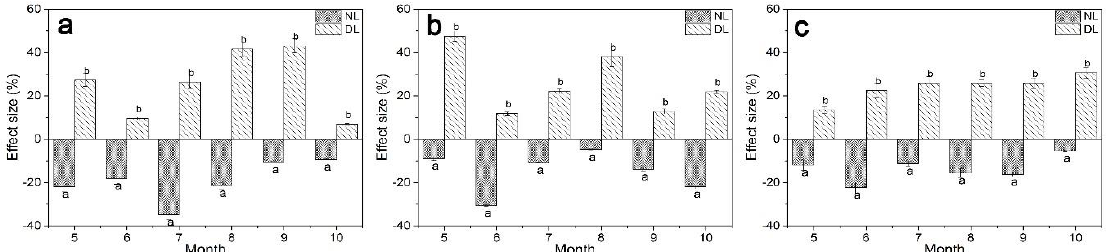
Figure 2. Effect size of NL (no-litter) and DL (double litter) treatments on soil respiration rates during the study period (May to October in 2018) in different-aged Betula platyphylla forests of the permafrost region, Northeast China. Stand ages included 25 ( a ), 40 ( b ) and 61 ( c ). We calculated the effect size of litter manipulation on Rs, compared to Rs under control litter input using the following equation: Effect size (%) = (R NL(DL) − R CK )/R CK × 100, where R NL , R DL and R CK are the mean R s under no-litter, double liter and control litter treatment. Error bars indicate the standard deviation ( n = 9). Lowercase letters represent significant differences under the same month and varied litter manipulation ( p < 0.05).